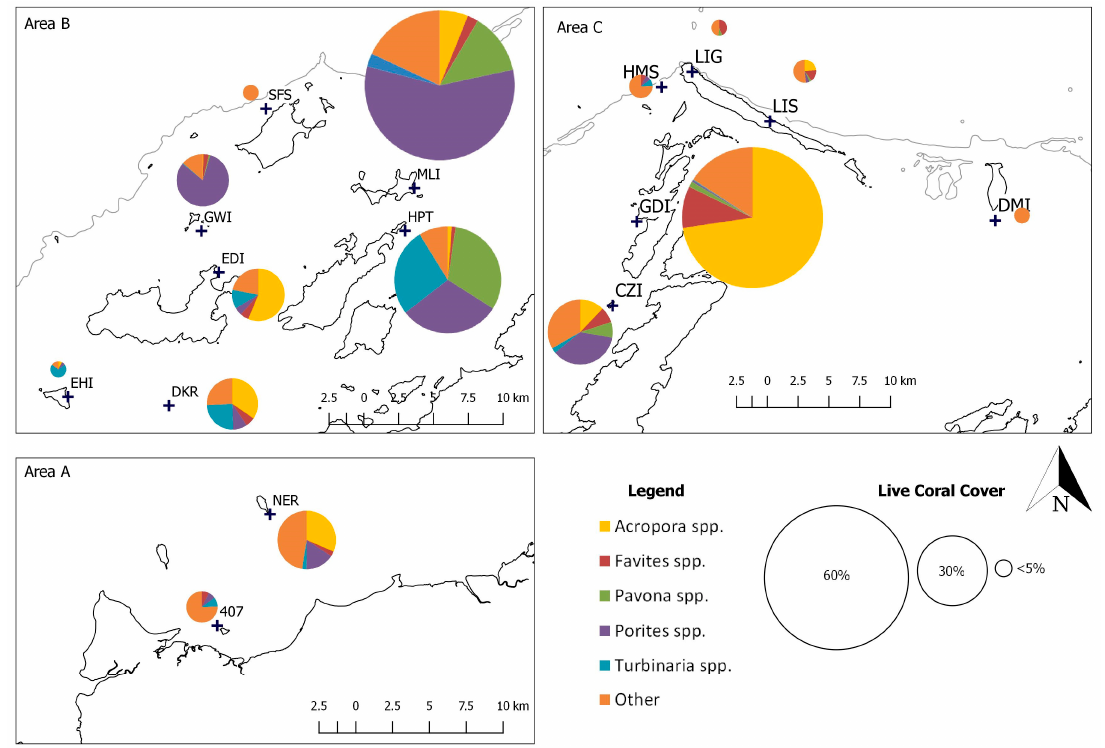
Figure 3. Percent cover of coral and breakdown of most abundant coral genera at 15 sites throughout the Dampier Archipelago, Western Australia in 2017. Site abbreviations: 407 = Unnamed 407, NER = North East Regnard, EHI = Eaglehawk Island, DKR = Dockrell Reef, EDI = Enderby Island, GWI = Goodwin Island, HPT = High Point, SFS=Sailfish, MLI = Malus Island, CZI = Conzinc Island, GDI = Gidley Island, HMS = Hammersley Shoal, LIG = Legendre Island Gen, LIS = Legendre Island SZ, DMI = Delambre Island. Areas A, B and C refer to subsets of the entire study area (see Figure 1).